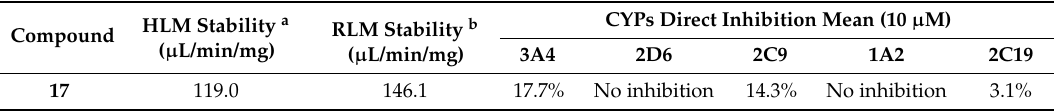
Table 2. In vitro DMPK profile.